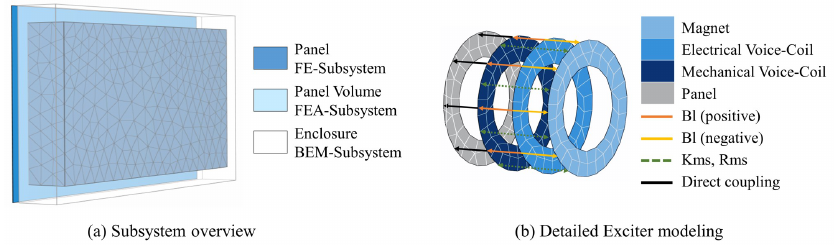
Figure 3. Overview of the simulation model. ( a ) Description of the individual subsystems consisting of the FE, FEA and BEM subsystems. ( b ) Detailed exciter modeling to visualize the model of the magnet mass, which is coupled via a transfer impedance to the mechanical part of the voice